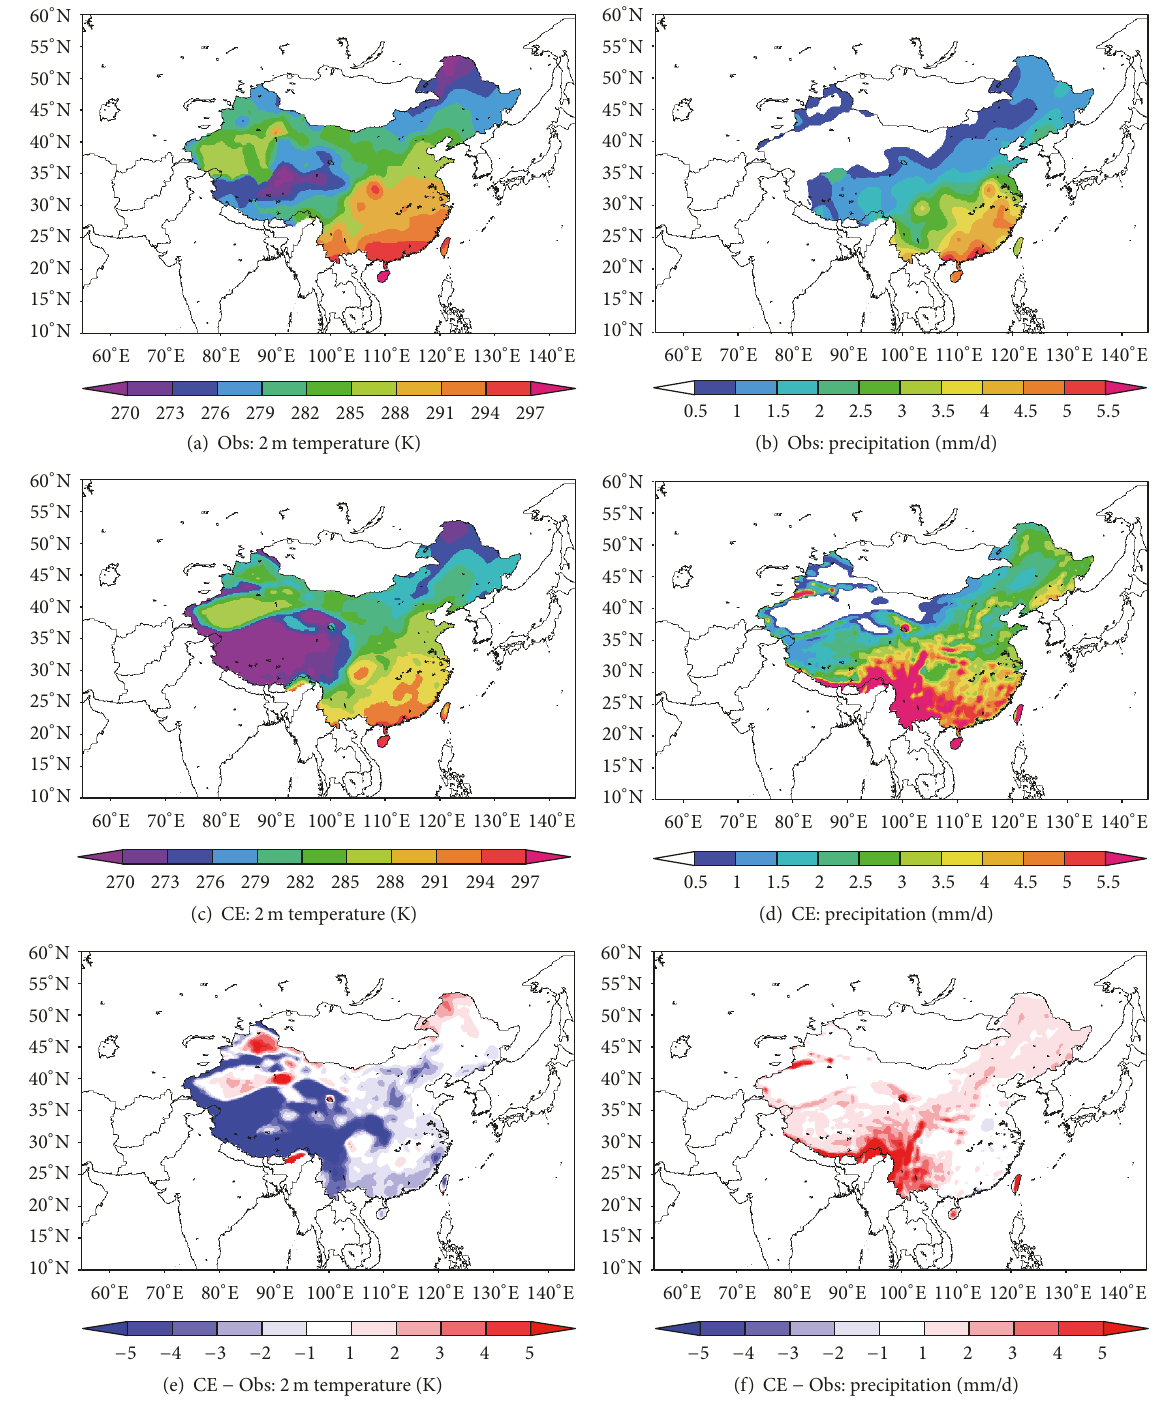
Figure 5: Comparison of mean temperature and precipitation averaged from 1 March 2001 to 1 March 2011 between observation and simulation. (a) Observed 2 m temperature (K) from 668 stations; (b) observed precipitation (mm/d) from 668 stations; (c) simulated 2 m temperature (K); (d) simulated precipitation (mm/d); (e) differences of 2 m temperature (K); and (f) differences of precipitation (mm/d) between simulation and observation (simulation –